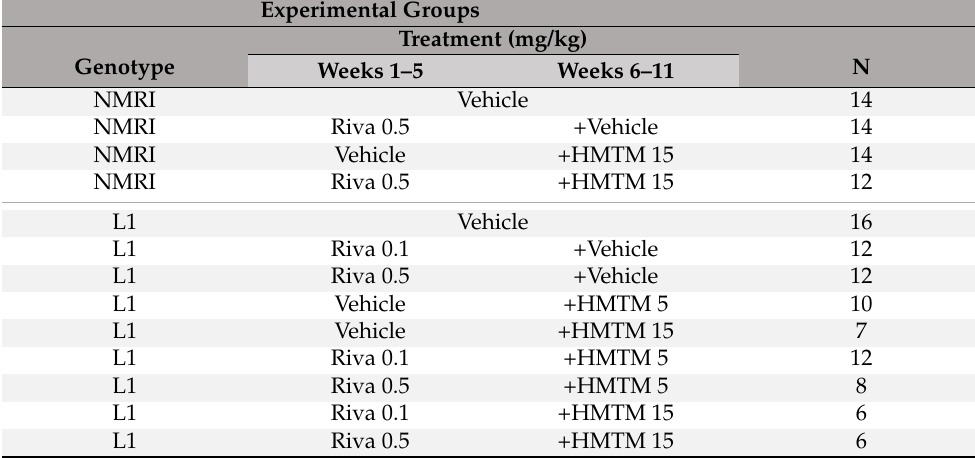
Figure 1. Schematic representation of the experimental design. All mice were female and aged 5.5 months at the start of the study, and the total duration of treatment was 11 weeks. NMRI mice were administered daily with vehicle or rivastigmine (0.5 mg/kg) and following that, after 5 weeks, HMTM (15 mg/kg) was added as monotherapy or add ‐ on therapy. L1 mice were dosed with either vehicle or one of two different doses of rivastigmine (0.1 and 0.5 mg/kg) or HMTM (5 and 15 mg/kg) as monotherapy or add ‐ on therapy. Table 1. Summary of the number of experimental conditions initially planned and total number of mice (N) tested for each group. Riva, rivastigmine; HMTM, hydromethylthionine mesylate.